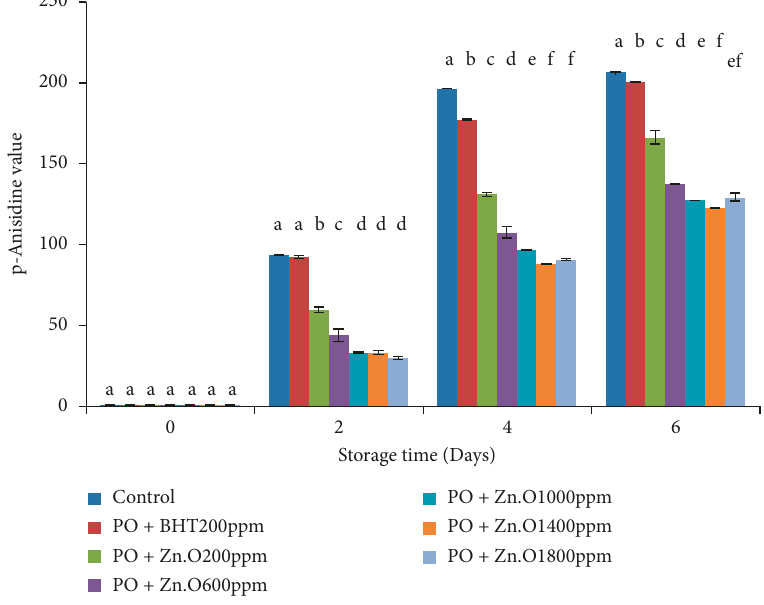
Figure 2: Variations in p -anisidine value of palm olein enriched with different concentrations of ginger extract during storage at frying temperature. BHT: butylated hydroxytoluene; PO: palm olein; Zn.O: Zingiber officinale (ginger); control: palm olein without antioxidant; PO+BHT 200 ppm : palm olein+ 200ppm BHT; PO +Zn.O 200ppm : palm olein+200ppm ginger root extract; PO +Zn.O 600ppm : palm olein+600ppm ginger root extract; PO+Zn.O 1000ppm : palm olein+1000ppm ginger root extract; PO+Zn.O 1400ppm : palm olein+1400ppm ginger root extract; and PO+Zn.O 1800ppm : palm olein +1800ppm ginger root extract. Data are presented as mean- ± standard deviation ( n � 3). a–f values of the same storage day with different superscripts differ considerably at p < 0 .